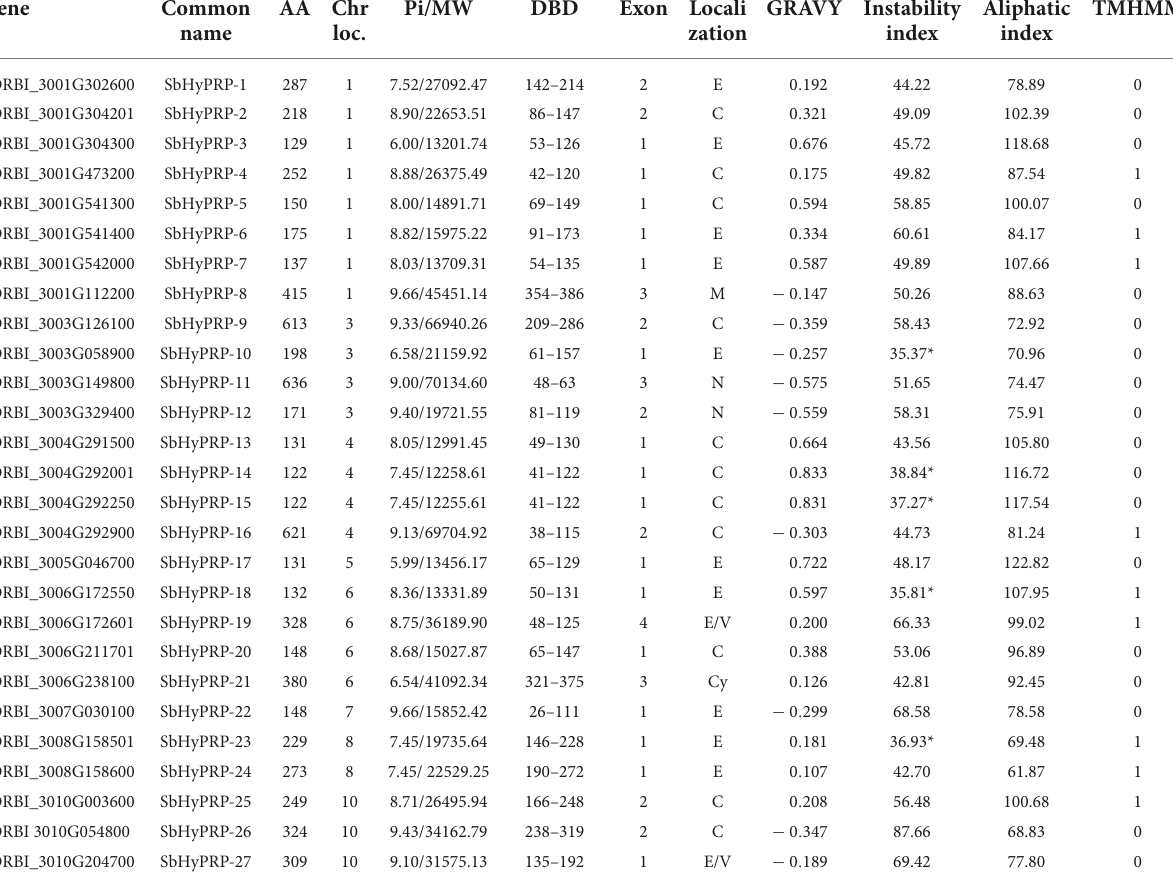
TABLE 2 List of identified HyPRPs exhibiting chromosomal location, length of aa, DNA binding domains (DBD), molecular weight (MW), iso-electric point (pI), GRAVY, no. of exons, localization, and instability and aliphatic indexes.